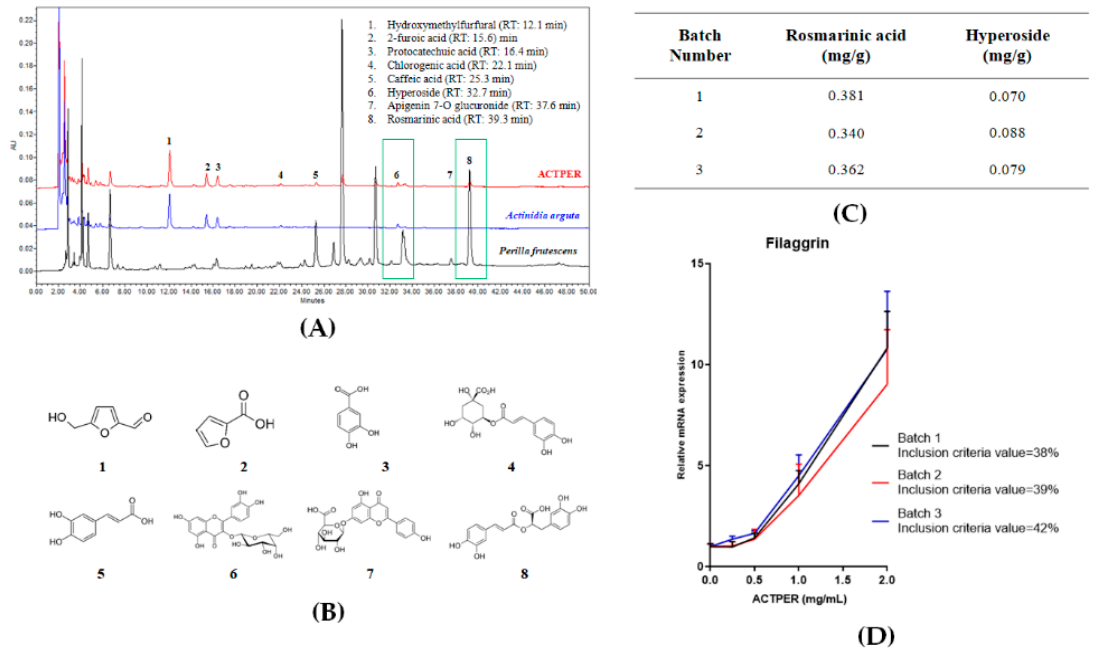
Figure 1. Description of the quality control of ACTPER. ( A ) Representative high-performance liquid chromatography (HPLC) chromatogram of ACTPER; ( B ) Molecular structure of chemical compounds contained in ACTPER; ( C ) Quantification of marker compounds hyperoside and rosmarinic acid; ( D ) Cell-based bioassay using HaCaT cells. Values represent the mean ± S.E.M. of three independent experiments.